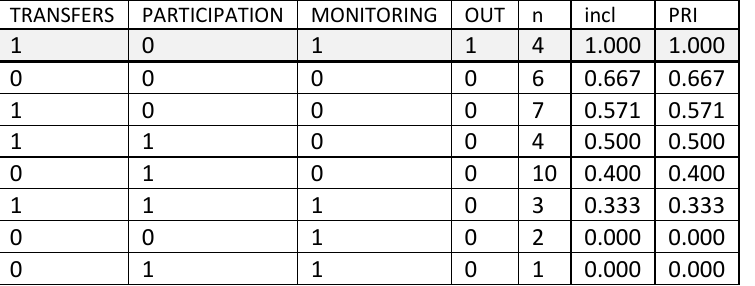
Table A2.9 Truth table for analysis of sufficiency for successful drought adaptation without CLUSTER